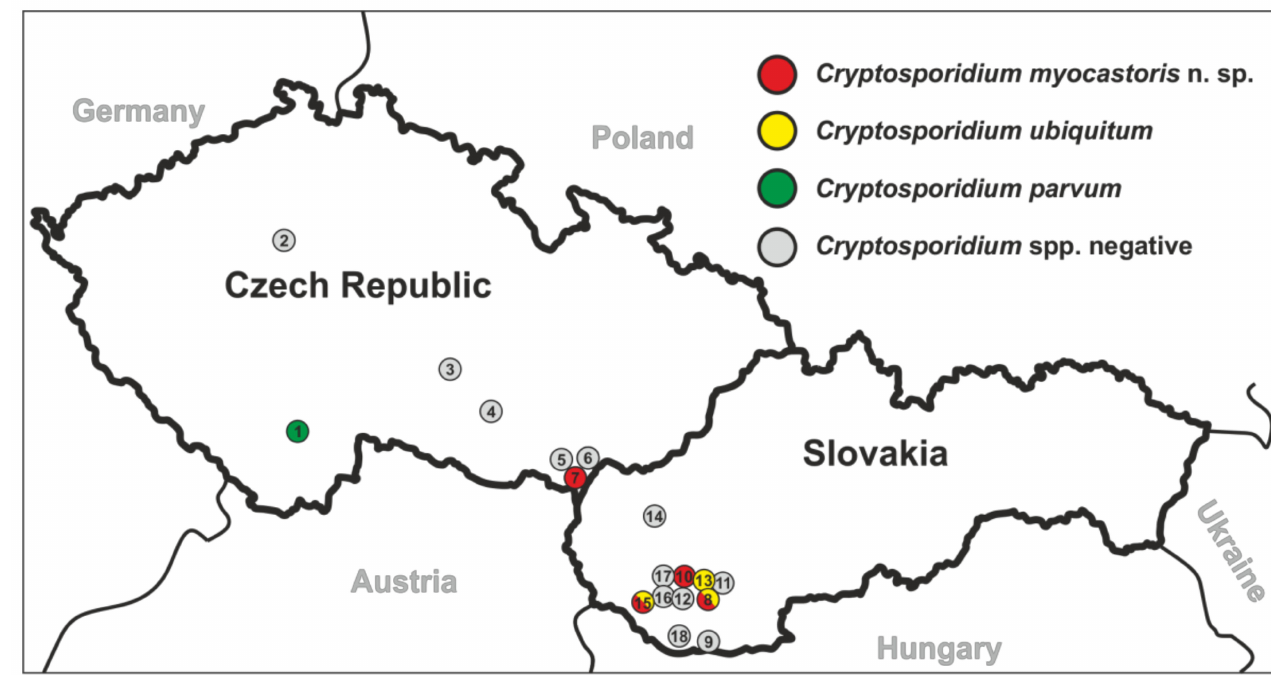
Figure 1. Sampling localities in the Czech Republic and Slovakia. For each site, the number indicates the name of locations ( 1 ) Plan á nad Lužnic í (N 49 ◦ 21.11527 (cid:48) , E 14 ◦ 42.08325 (cid:48) ); ( 2 ) Praha (N 50 ◦ 4.78070 (cid:48) , E 14 ◦ 24.81330 (cid:48) ); ( 3 ) Jihlava (N 49 ◦ 23.09785 (cid:48) , E 15 ◦ 36.37422 (cid:48) ); ( 4 ) Tˇreb í ˇc (N 49 ◦ 12.58360 (cid:48) , E 15 ◦ 52.28832 (cid:48) ); ( 5 ) Bˇreclav (N 48 ◦ 46.34147 (cid:48) , E 16 ◦ 52.68835 (cid:48) ); ( 6 ) T ý nec (N 48 ◦ 46.31570 (cid:48) , E 17 ◦ 0.66778 (cid:48) ); ( 7 ) Lanžhot (N 48 ◦ 43.41558 (cid:48) , E 16 ◦ 58.30782 (cid:48) ); ( 8 ) Nov é Z á mky (N 48 ◦ 0.76540 (cid:48) , E 18 ◦ 11.75573 (cid:48) ); ( 9 ) Kom á rno (N 47 ◦ 45.04053 (cid:48) , E 18 ◦ 8.98083 (cid:48) ); ( 10 ) Šal’a (N 48 ◦ 9.08273 (cid:48) , E 17 ◦ 52.49152 (cid:48) ); ( 11 ) Don ý Ohaj (N 48 ◦ 4.33237 (cid:48) , E 18 ◦ 14.81102 (cid:48) ); ( 12 ) Topoln í ky (N 47 ◦ 57.61112 (cid:48) , E 17 ◦ 45.37918 (cid:48) ); ( 13 ) Pal á rikovo (N 48 ◦ 2.15190 (cid:48) , E 18 ◦ 2.70193 (cid:48) ); ( 14 ) Nitriansk ý Hr á dok (N 48 ◦ 3.62700 (cid:48) , E 18 ◦ 12.56517 (cid:48) ); ( 15 ) Dunajsk á Streda (N 47 ◦ 55.90470 (cid:48) , E 17 ◦ 28.42662 (cid:48) ); ( 16 ) Vlˇcny (N 48 ◦ 2.69967 (cid:48) , E 17 ◦ 57.72202 (cid:48) ); ( 17 ) Diakovce (N 48 ◦ 8.02725 (cid:48) , E 17 ◦ 50.48138 (cid:48) ); and ( 18 ) Lipov é (N 47 ◦ 50.41113 (cid:48) , E 17 ◦ 51.33057 (cid:48) ). The colour indicates the presence of Cryptosporidium